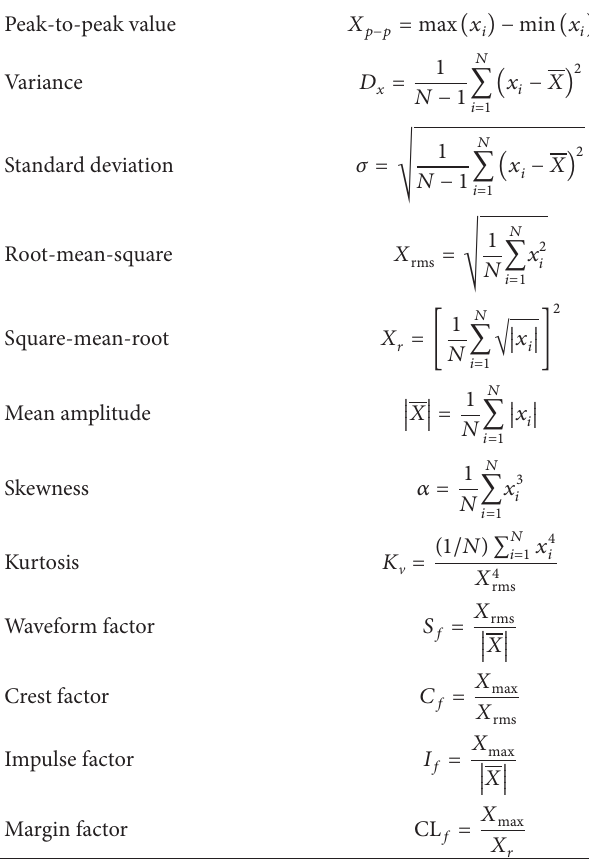
Table 1: Amplitude parameter formulas. Peak-to-peak